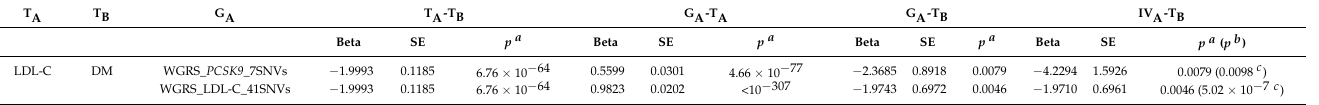
Table 3. Summary of coefficients used for standard Mendelian randomization analysis: low-density lipoprotein cholesterol (LDL-C) levels and diabetes mellitus